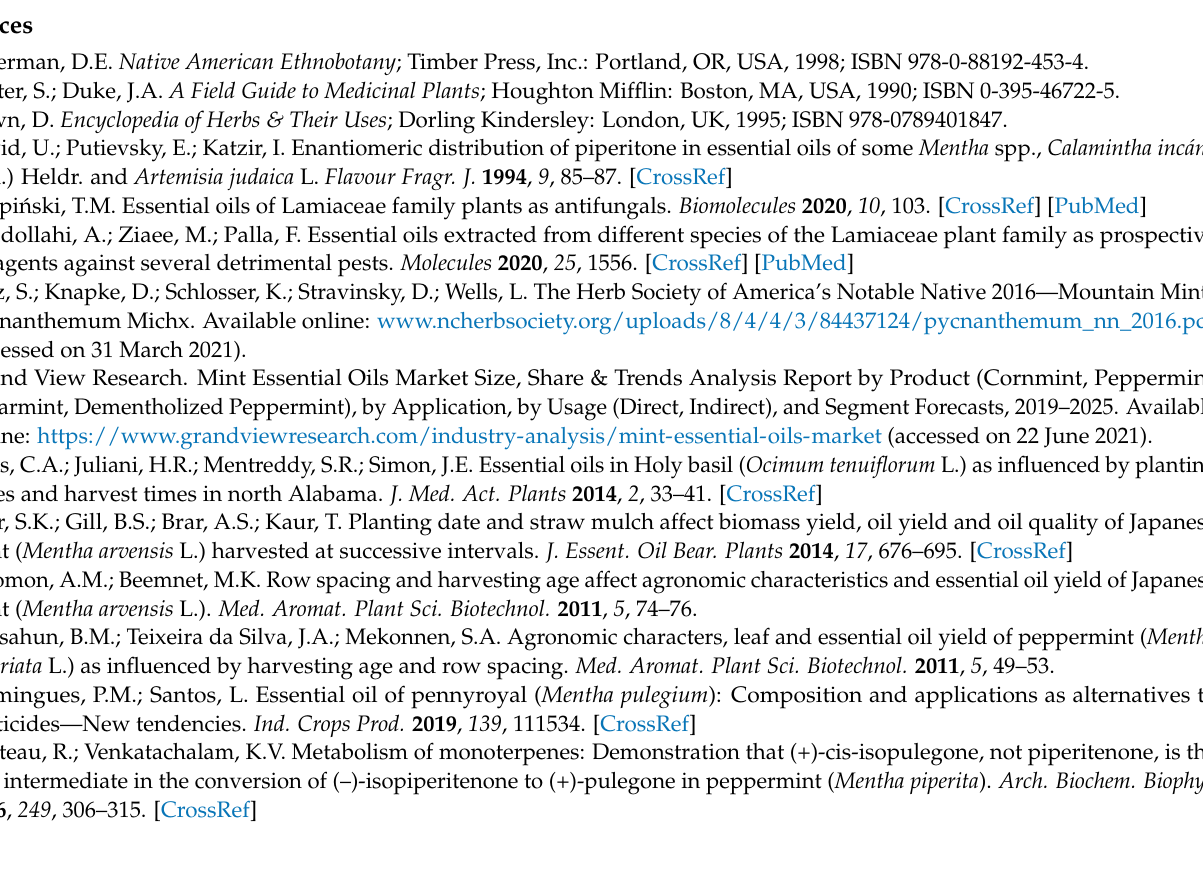
Table S5: Enantiomeric distribution of terpenoid constituents of Pycnanthemum virginianum , variety M1, Table S6: Enantiomeric distribution of terpenoid constituents of Pycnanthemum virginianum , variety M2, Table S7: Enantiomeric distribution of terpenoid constituents of Pycnanthemum virgini- anum , variety M3, Table S8: Enantiomeric distribution of terpenoid constituents of Pycnanthemum virginianum , variety